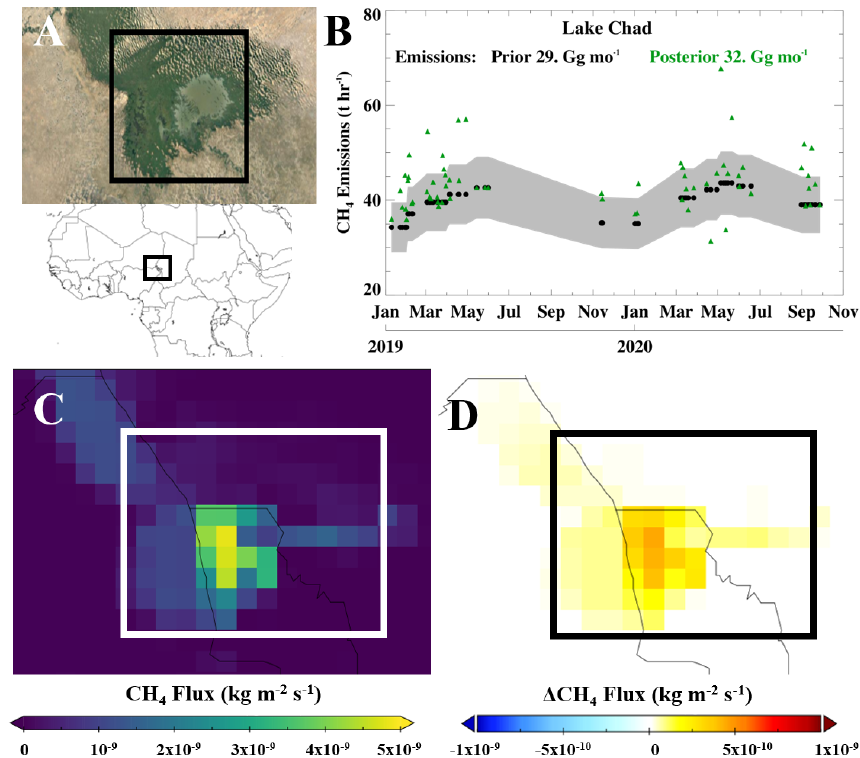
Figure 5. (a) The Lake Chad domain indicated by the black box (© Google Maps, 2021). (b) Time series of total prior (black circles) and posterior (green triangles) CH 4 emission estimates within the 1 ◦ × 1 ◦ domain, centred around 13.0 ◦ N, 14.3 ◦ E for 2019–2020, excluding days for which observations were not available. The shaded error denotes prior uncertainty. (c) Average prior CH 4 emissions for 2019. (d) Average posterior minus prior CH 4 emissions for January–June 2019, excluding days for which observations were not